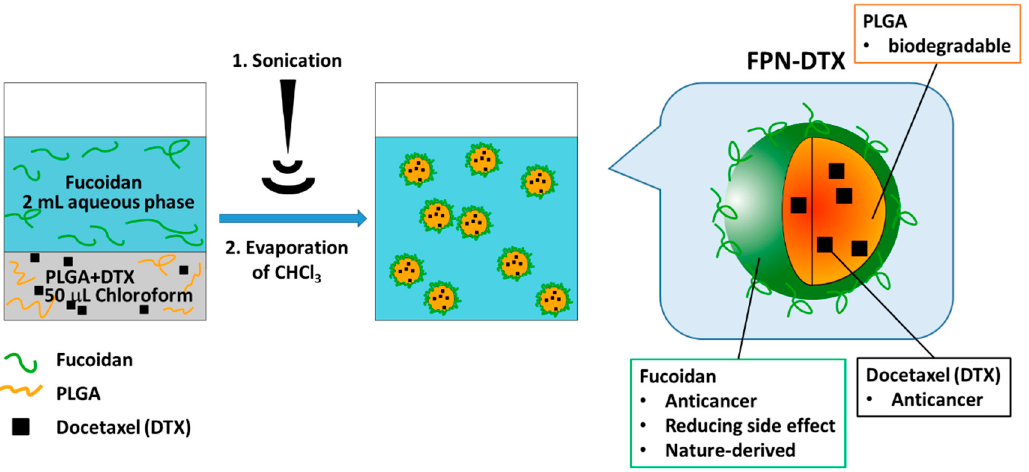
Table 2. Formulations and their corresponding encapsulated amounts, encapsulation efficiency (EE), and loading capacity of FPNs–DTX for docetaxel. Data in the table are the mean ± SD, n = 3. Fucoidan:PLGA